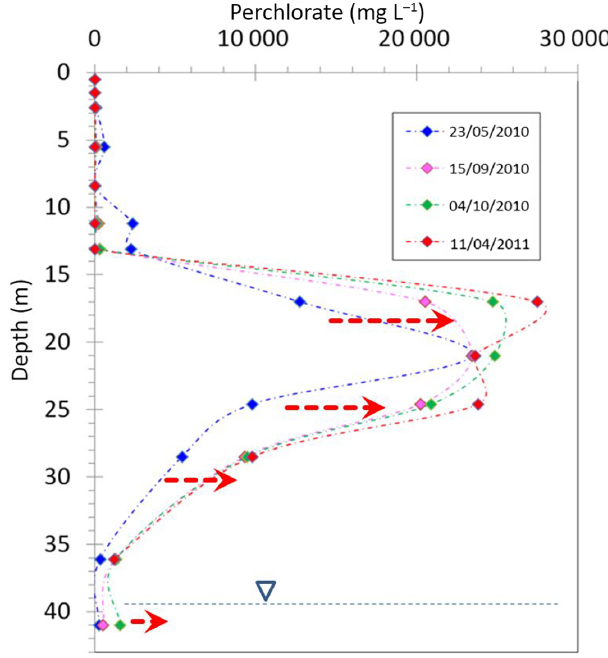
Figure 4. Perchlorate concentration profile across the top 13m of the vadose zone under the pilot site during the infiltration experi- ments. The profiles emphasize the gradual decrease in perchlorate concentration with time (marked in red arrows). Dates are given as day/month/year. Note that data points are aligned in a slanted orien- tation and interpolated as time intervals.